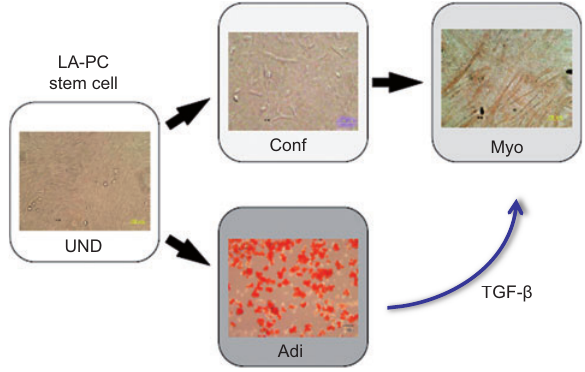
Figure 2 LA-PCs comprise a mixed population of stem cells and the progenitors for skeletal/cardiac myocytes (Myo) or adipocytes